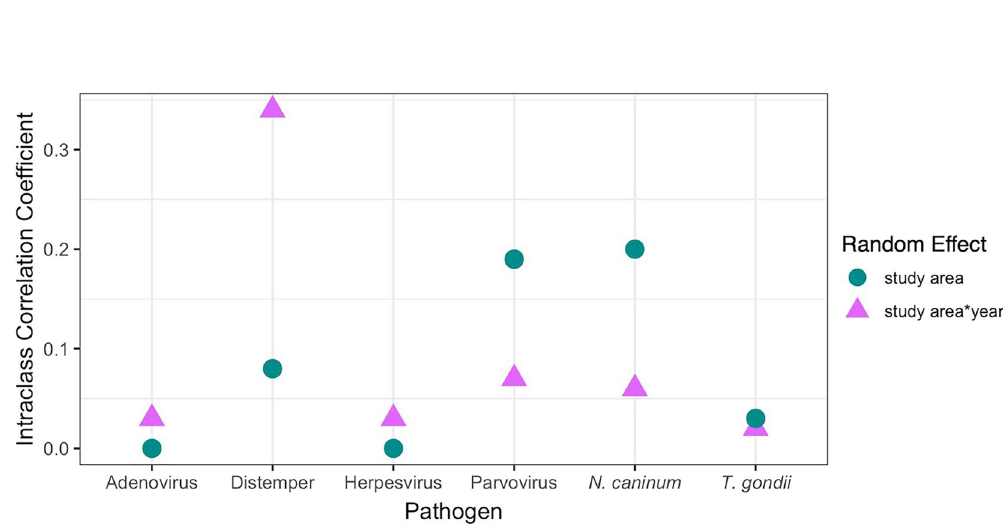
Figure 5. Intraclass correlation coefficient values for the random effects from the complete models : study area (teal circles) and study area*year (purple triangles) 39